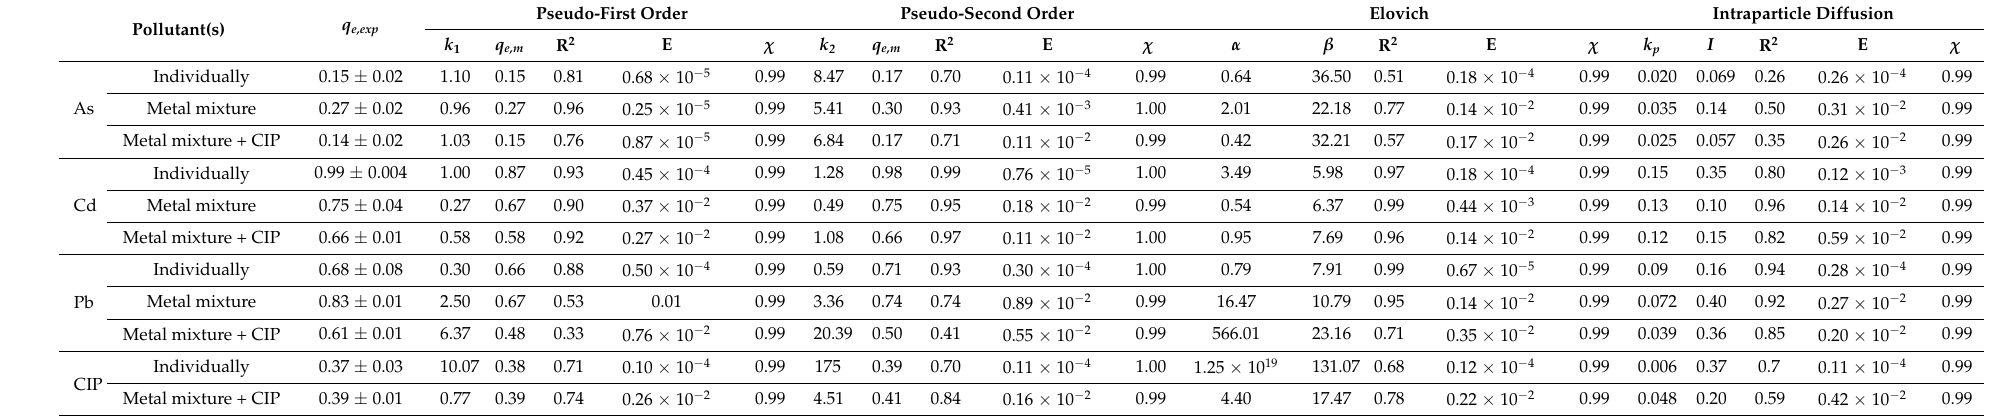
Table 4. Kinetic parameters of the pollutants’ adsorption onto chitosan-biochar